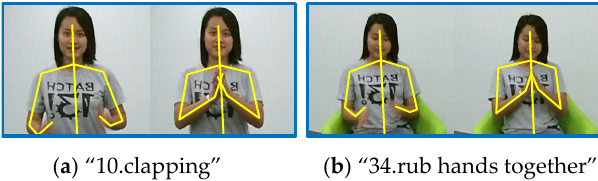
( a ) “10.clapping” ( b ) “34.rub hands together” Figure 8. Two examples for class “10.clapping” and class “34.rub hands together”. The yellow lines represent the skeletons.